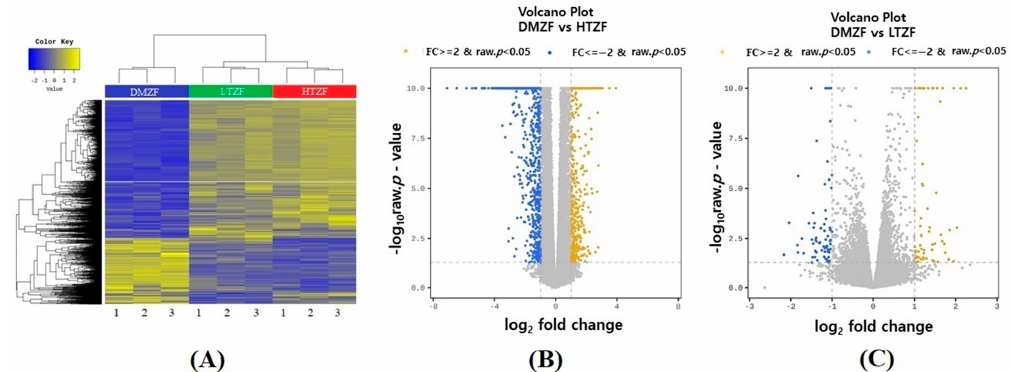
Figure 5. ( A ) Heat map of differential expression between DMZF, LTZF, and HTZF. Two-way hierarchical clustering heat map using the z-score for normalized values (log2-based). ( B ) Volcano plot of dimethylsulfoxide-treated zebrafish (DMZF) vs. 4.0 μ g/L thiram-treated fish (HTZF). ( C ) Volcano plot of DMZF vs. 0.4 μ g/L thiram-treated zebrafish (LTZF). Each blue colored dot indicates a downregulated gene (FDR < 0.05 and FC ≤ − 2), and each yellow dot indicates an upregulated gene (FDR < 0.05 and FC ≥ 2).